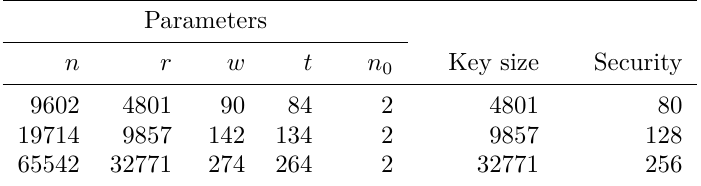
Table 1: Proposed QC-MDPC instances with key size and security level.